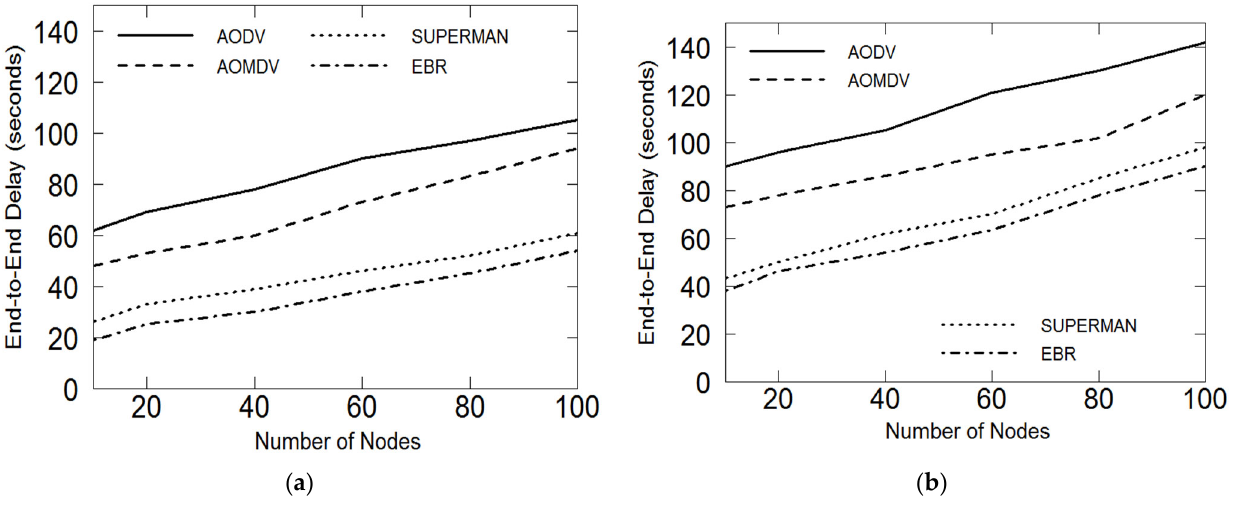
Figure 2 ( a ) End ‐ to ‐ end delay vs. number of nodes (without attack); ( b ) End ‐ to ‐ end delay vs. Figure 2. ( a ) End-to-end delay vs. number of nodes (without attack); ( b ) End-to-end delay vs. number number of nodes (with attack). of nodes (with